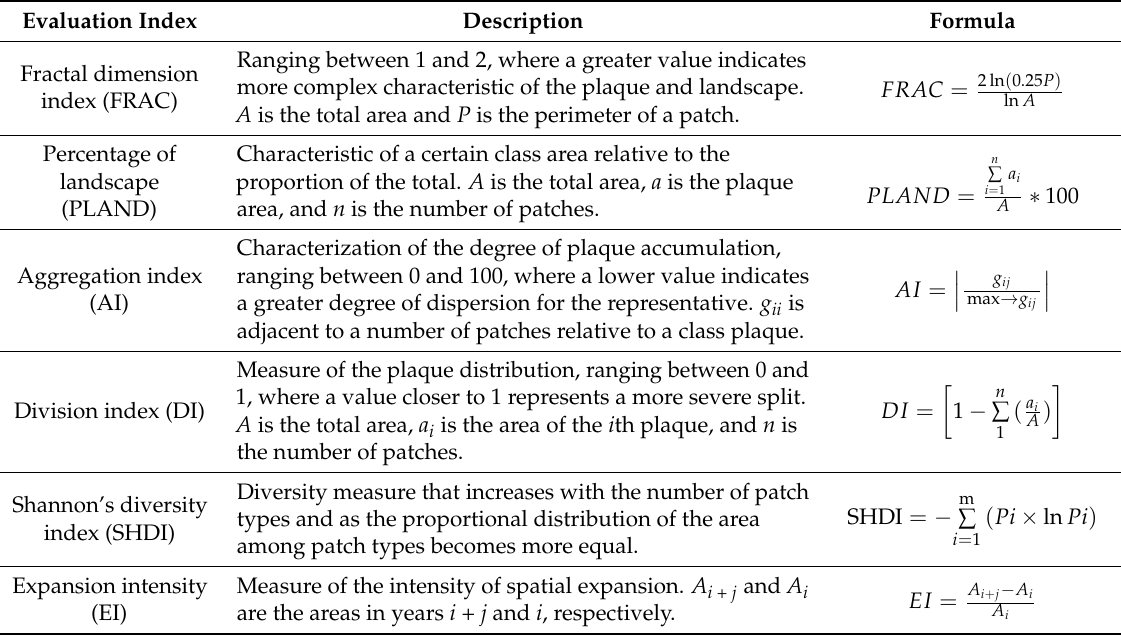
Table 4. Evaluation indices for LST and LUCC types